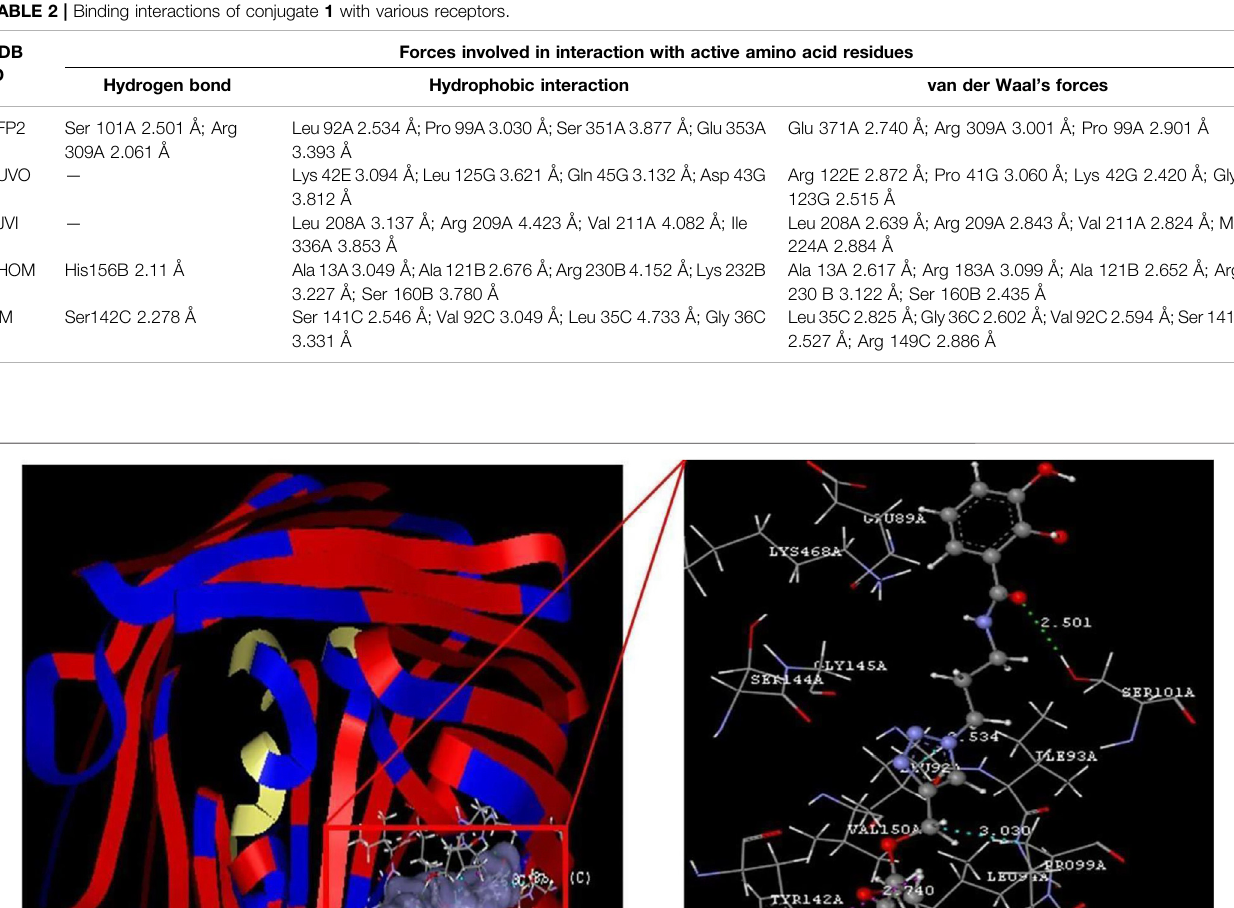
TABLE 2 | Binding interactions of conjugate 1 with various receptors.